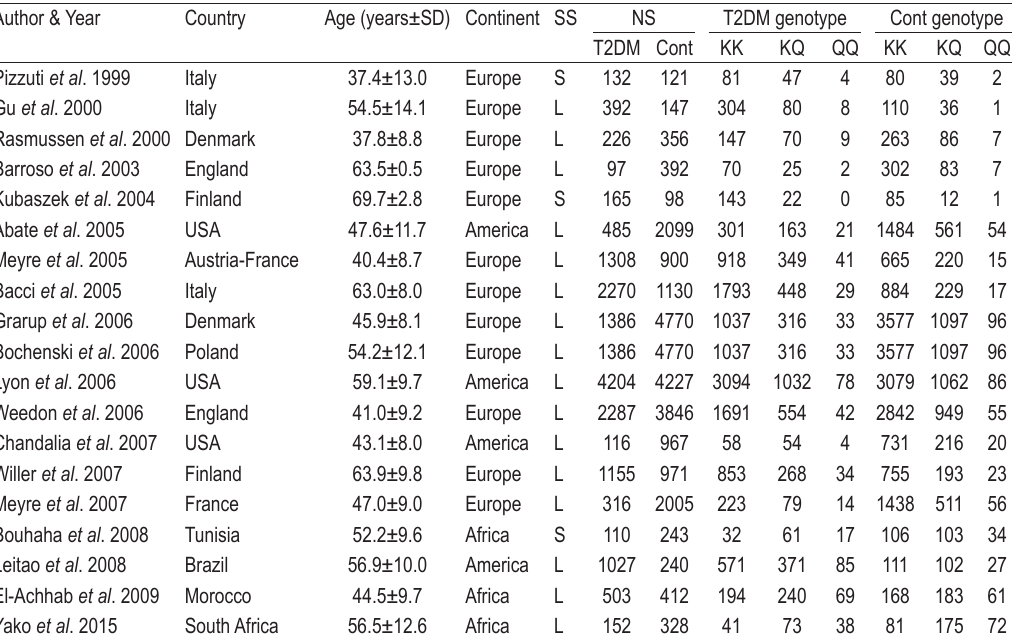
TABLE 1. Characteristics of studies included in the